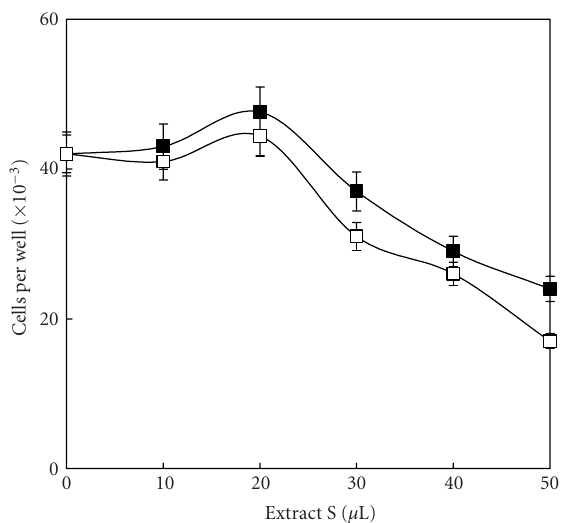
Figure 7. Inhibition of fibroblast growth by extract as super- natant ( (cid:1) ) and residue ( (cid:2) ), as shown in Figure 6. The values are means of 4–6 determinations per time point ± 1 SD.